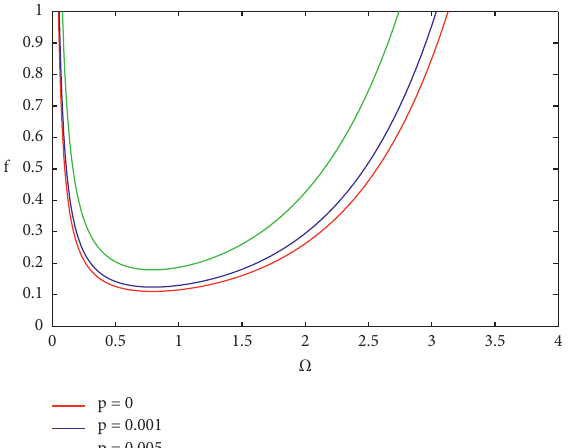
� √ − 1 ) /2 and for three different values of p . The 5